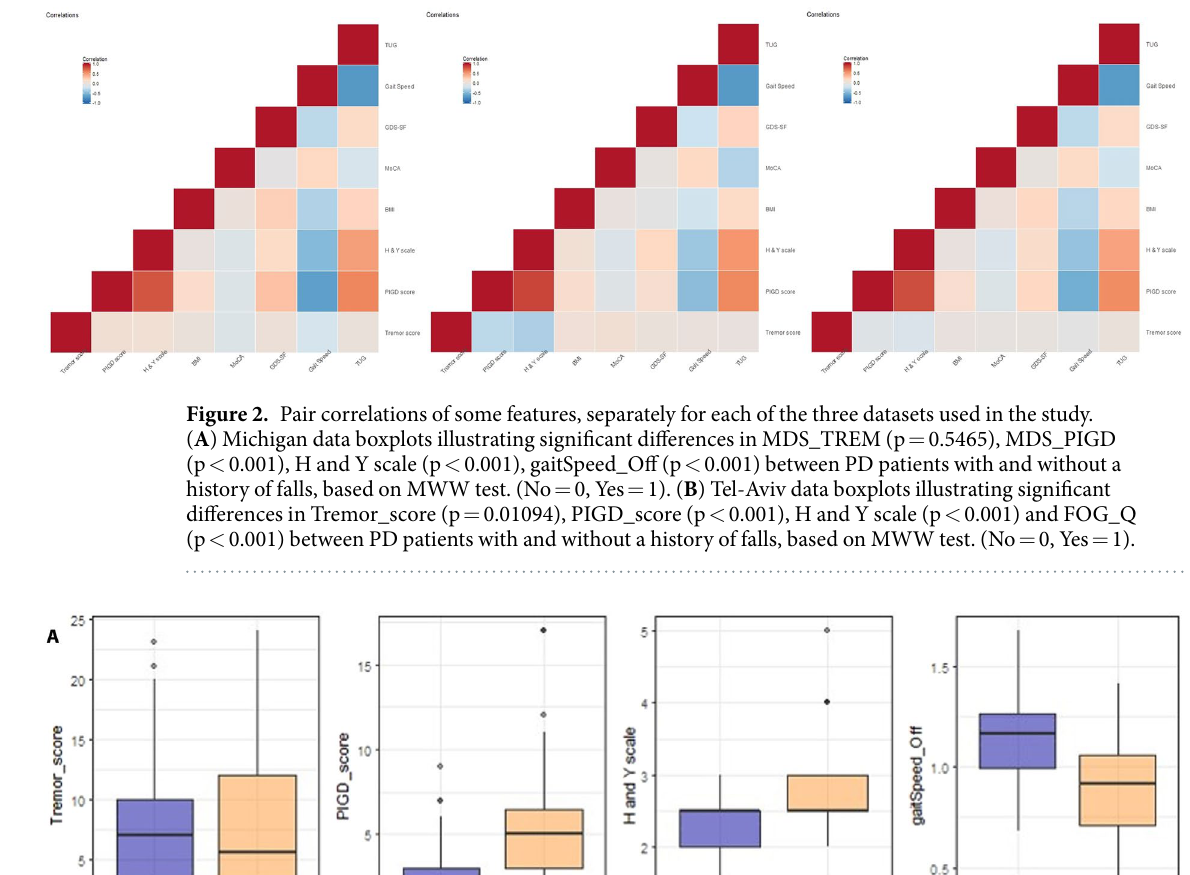
i.e., replaced by the minimum of the other non-zero p -values, to ensure that the logarithmic y-axis scale is cor- rectly plotted. False Discovery Rate (FDR) was used to control the false-positive rate at the level of 0.01. Thus, among the set of rejected null hypotheses, the expected proportion of false discoveries is limited to 1%. Assuming the tests are